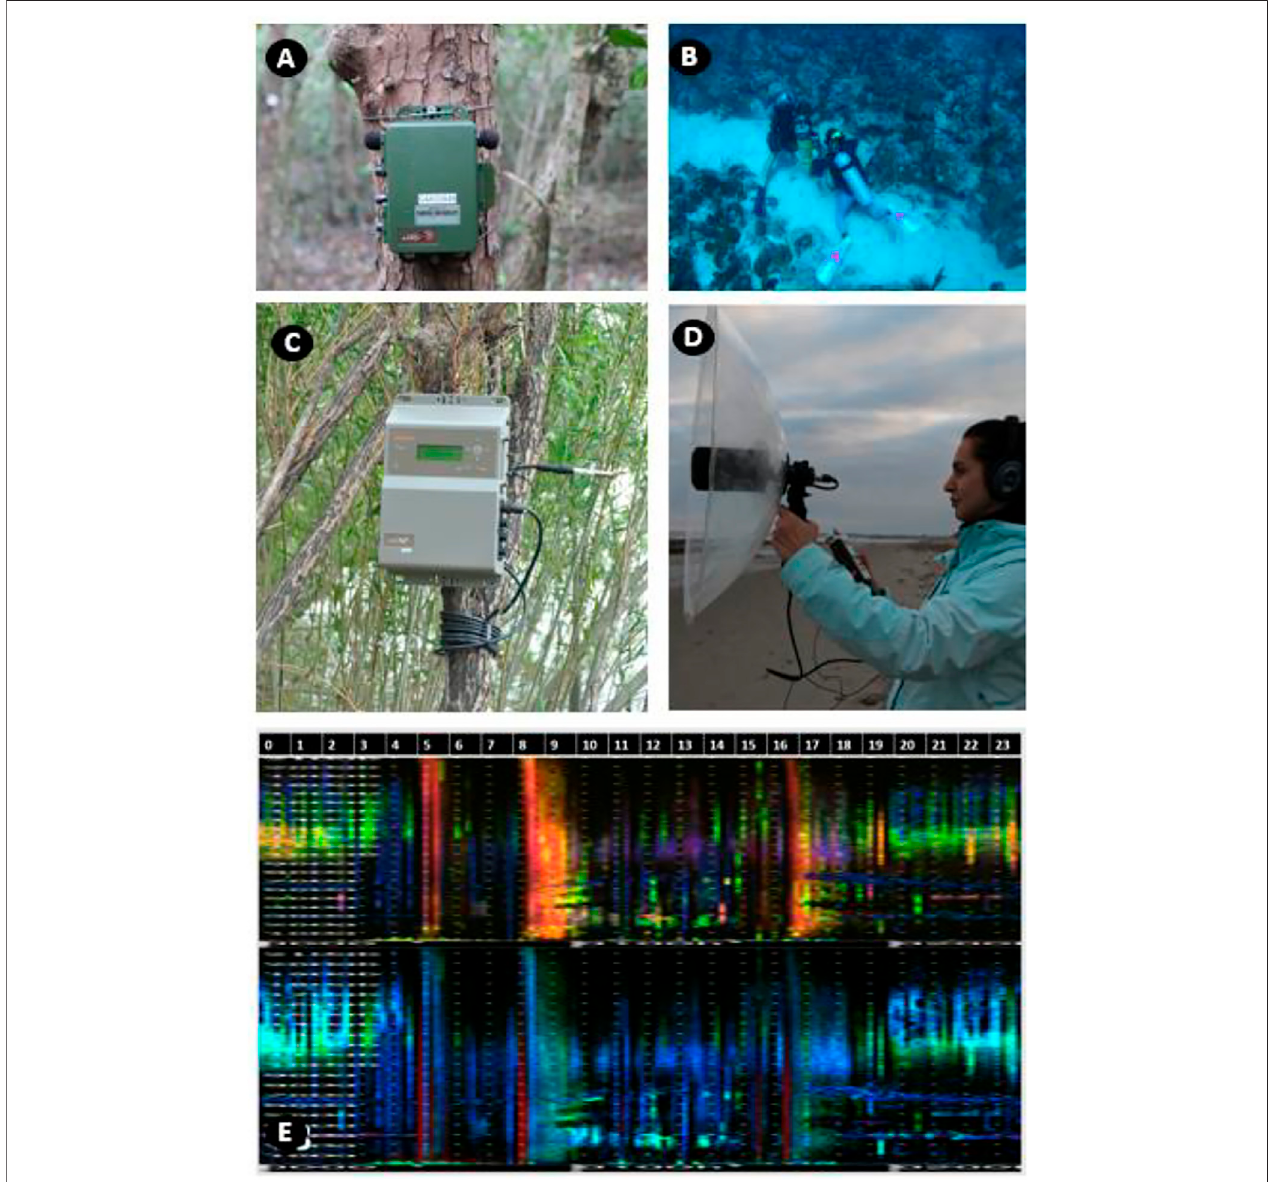
FIGURE2| Passiveacousticstechnologiesthatshow (A) aterrestrial passiveacousticrecordermountedtoatreeintheSundarbans,Bangladesh(photocreditB. Pijanowski), (B) a hydrophone being deployed in a Weinberg Reef, Puerto Rico (photo credits Jack Olson, Rebecca Becicka and Alex Veglia), (C) , an ultrasonic (bat) recorderalongtheTuulRiver,Mongolia(photocredit,B.Pijanowski), (D) ahand-heldparabolicdishmountedonahypercardioidmicrophone(photocredit,B.Pijanowski and M. Ghadiri) and (E) a false color spectrogram of 24 1-h recordings made in Feb, 2017 in Issa Valley, Tanzania (courtesy of Francesco Rivas Fuenzalida).